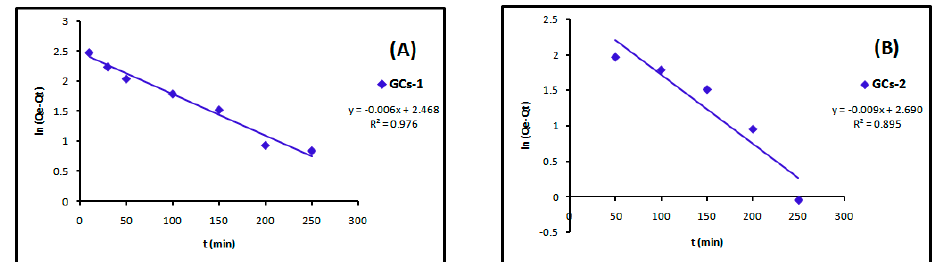
Figure 12. Cont. Figure 14.